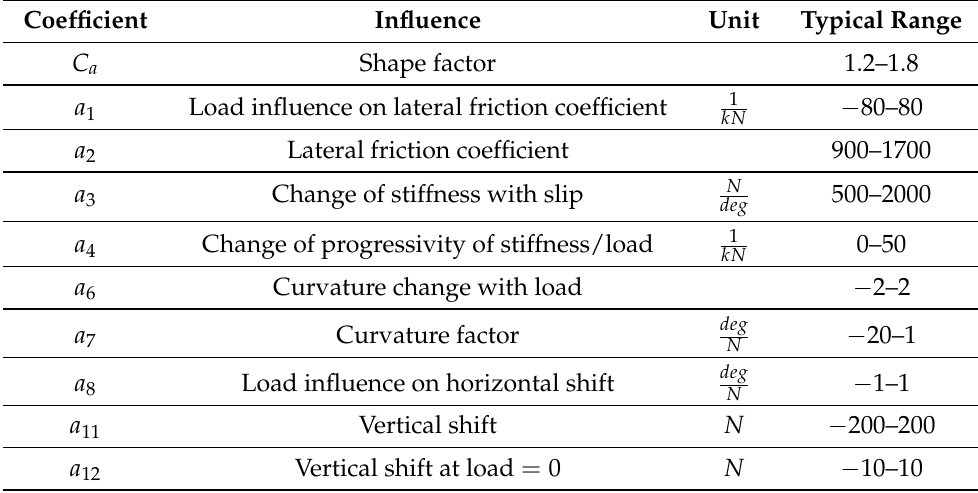
Table 1. Lateral coefficients for dry asphalt.